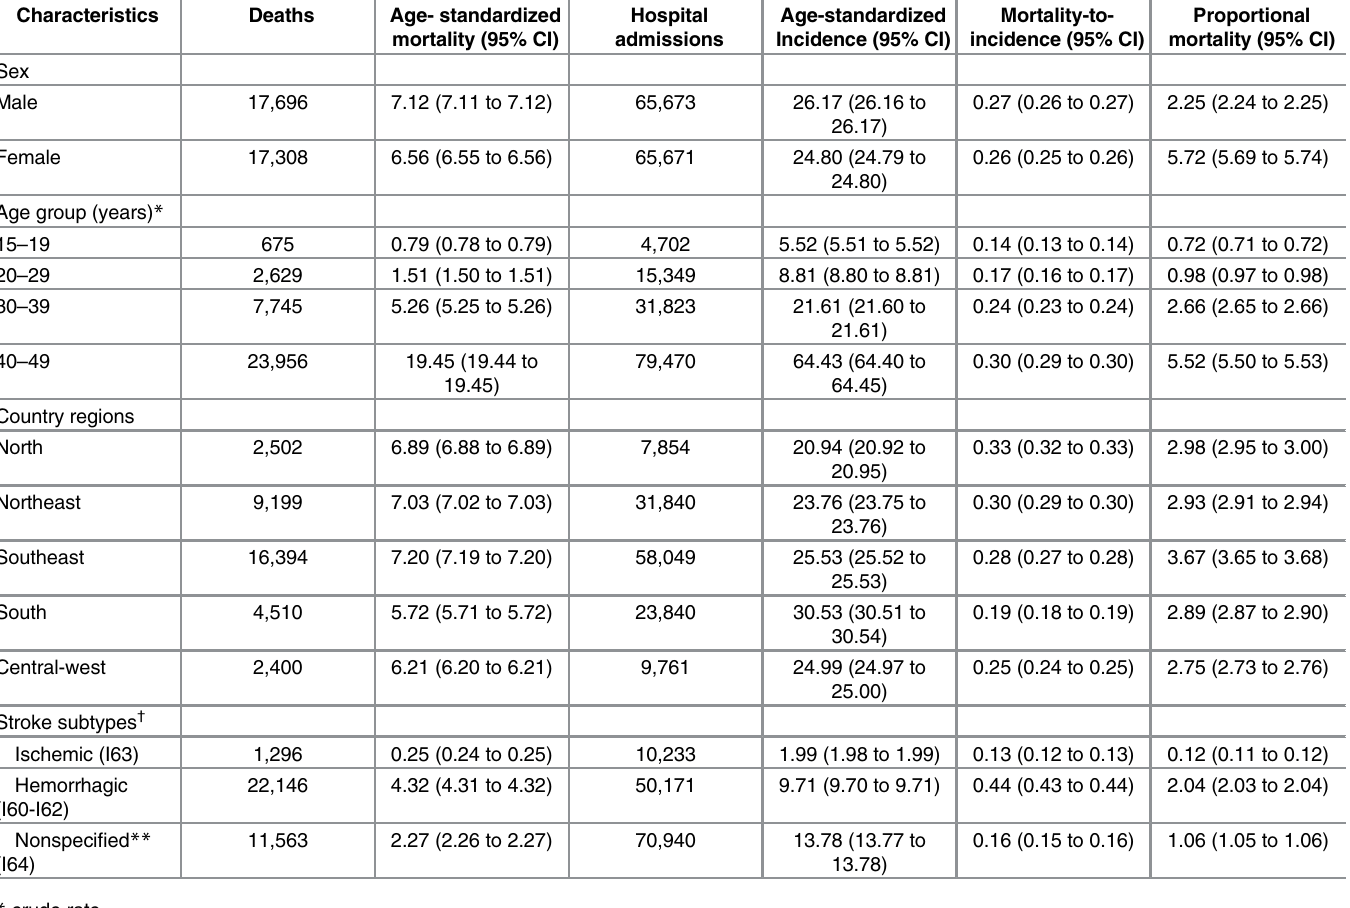
Table 1. Burden of stroke † in Brazilians aged 15 to 49 years during 2008 –